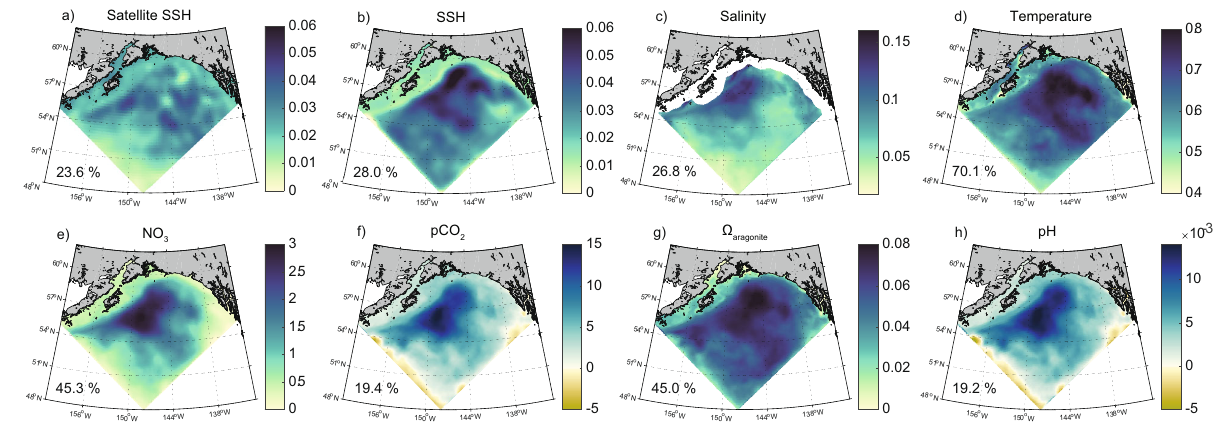
Fig. 1 Empirical orthogonal function (EOF) spatial patterns. Maps of the Empirical Orthogonal Function (EOF) spatial patterns of the fi rst mode of a satellite observed sea surface height (SSH, m, regridded to the model grid), b modeled SSH (m), and model surface c salinity, d temperature (°C), e NO 3 ( μ mol kg – 1 ), f pCO 2 ( μ atm), g saturation state for aragonite ( Ω arag ), and h pH calculated for the 1980 − 2013 period. The amount of variance associated with each EOF is shown at the lower-left corner of each map. The EOFs were computed based on the illustrated spatial domain and were applied to monthly model output after fi rst removing a long-term temporal trend using a quadratic function and second deseasonalizing the data. A 100 km wide band along the coast has been masked out for surface salinity to avoid the interference of freshwater from the coastal river and glacial discharge with the EOF analysis.